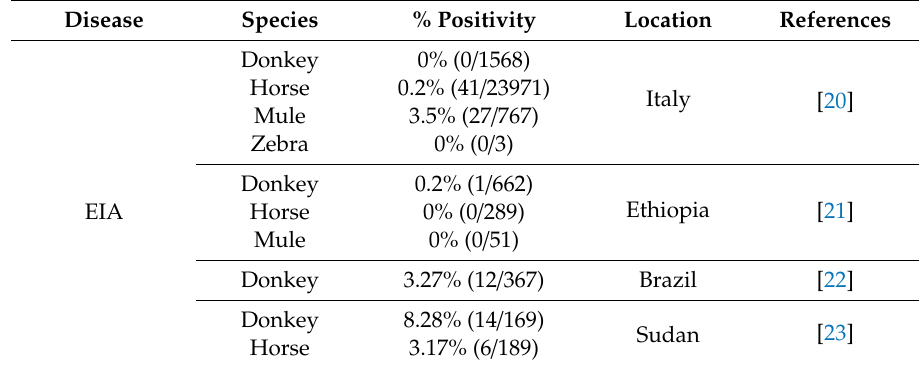
Table 2. Studies on the occurrence of equine infectious anemia (EIA) in horses, donkeys, mules and zebras from 2009 to